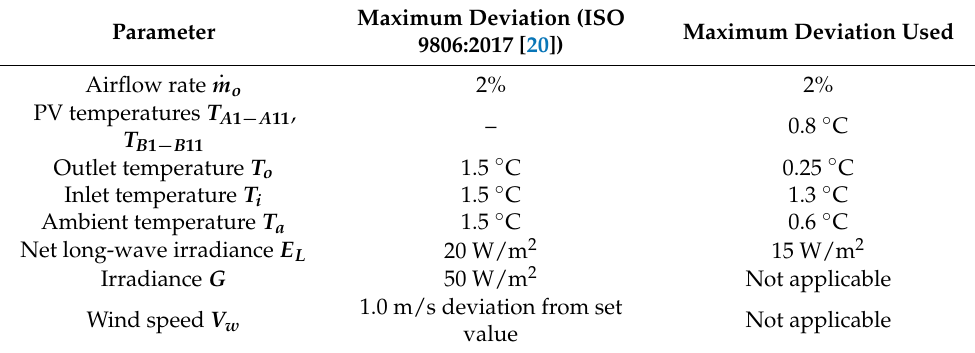
Table 5. Steady-state criteria for indoor